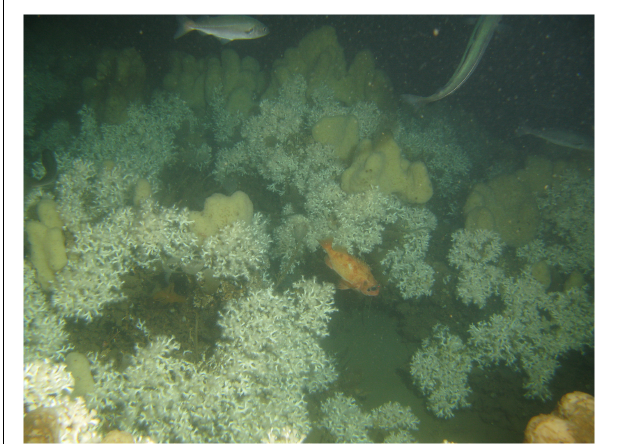
FIGURE 1 | Dense coverage of the cold-water scleractinian coral Lophelia pertusa at the Tisler reef with the sponge Mycale lingua growing within its framework, the fish Sebastes sp. and the fish Pollachius sp.